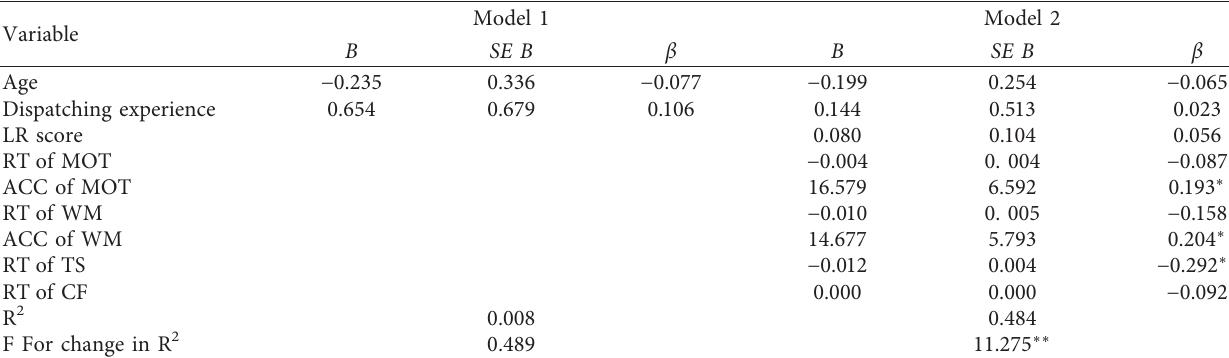
Table 4: Hierarchical regression coefficients for the prediction of safety evaluation.